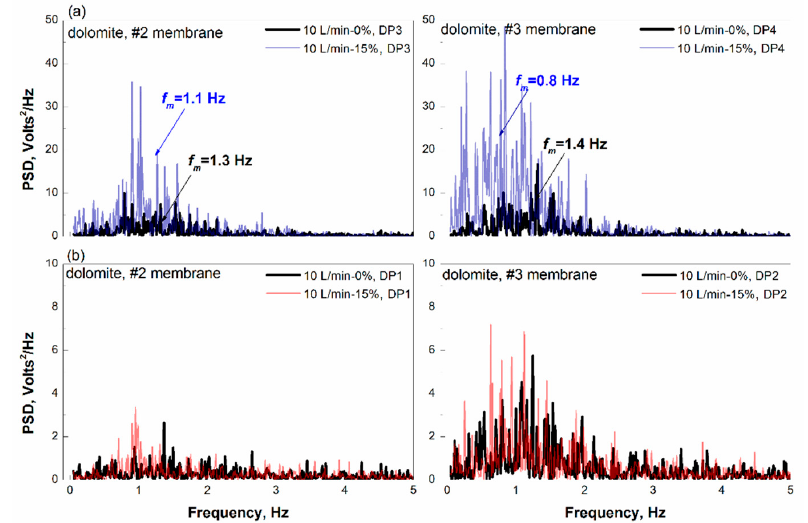
Figure 5. Comparison of the power spectra of the differential pressure in ( a ) the upward bed section and ( b ) the downward bed section measured at gas extraction and normal operational conditions. The other operational conditions were: T = 550 °C, P = 0.1 MPa, H ini = 1.28 m, U = 0.09 m/s, extraction rate = 1.5 L/min, calcined dolomite.